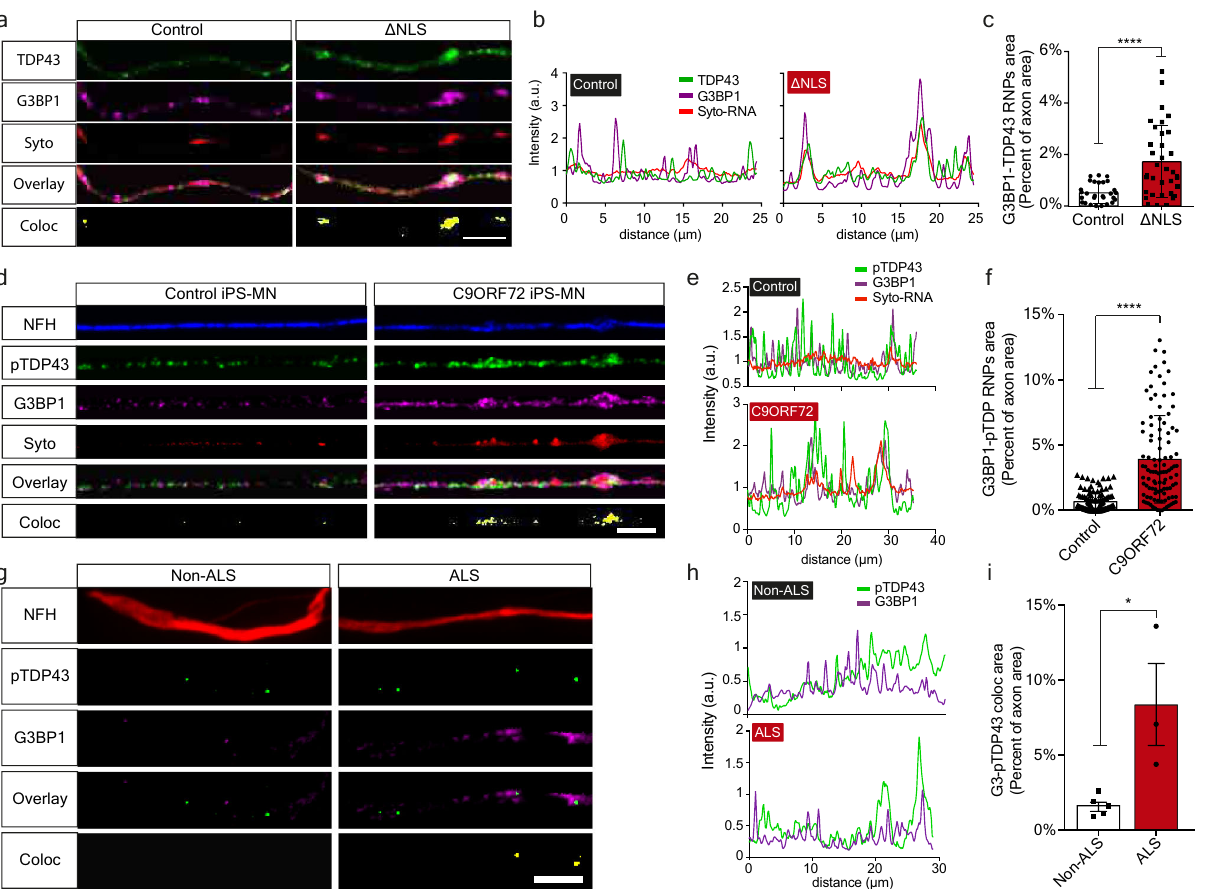
Fig. 2 Axonal TDP-43 accumulation leads to formation of pathological RNP condensates. a – c Images ( a ), colocalization pro fi les ( b ) and quanti fi cation ( c ) of TDP-43-G3BP1-SytoRNA colocalization in control or Δ NLS axons. Scale bar = 10 µ m. n = 28,35 axons. Data are presented as mean values ± SD. Unpaired- t -test, two-sided. **** p < 0.0001. d – f Images ( d ), colocalization pro fi les ( e ) and quanti fi cation ( f ) of pTDP-43-G3BP1-SytoRNA colocalization in control or C9ORF72 iPS-MN. Scale bar = 10 µ m. n = 108,104 axons. Data are presented as mean values± SD. Unpaired- t -test, two-sided, **** p < 0.0001. g – i Images ( g ), colocalization pro fi les ( h ) and quanti fi cation ( i ) of pTDP-43-G3BP1 colocalization in non-ALS or ALS patient intra-muscular nerves. Scale bar = 10 µ m. n = 5,3 patients. Data are presented as mean values ± SEM. Unpaired- t -test, two-sided. * P = 0.0163. a.u stands for arbitrary units. Source data are provided as a Source Data fi